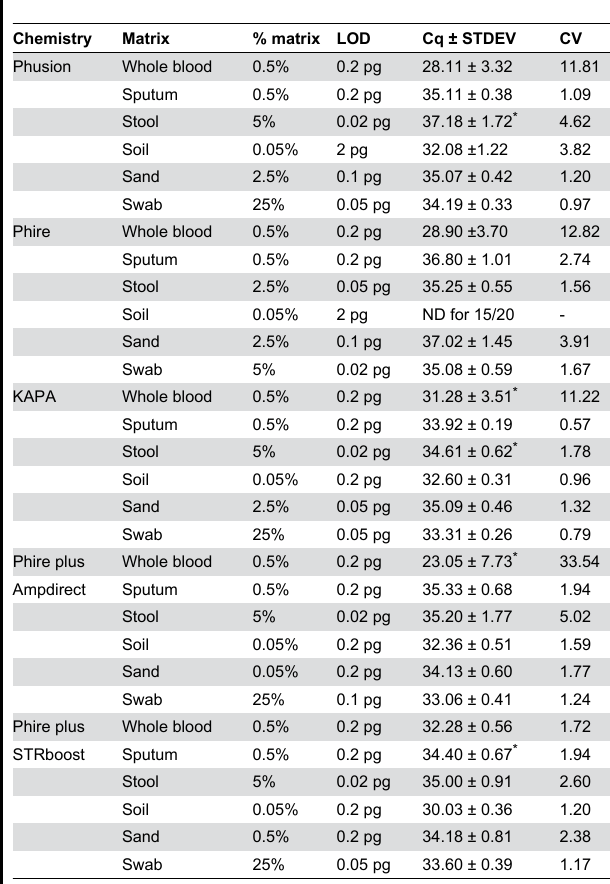
Table 7. Limits of detection (20/20) for each